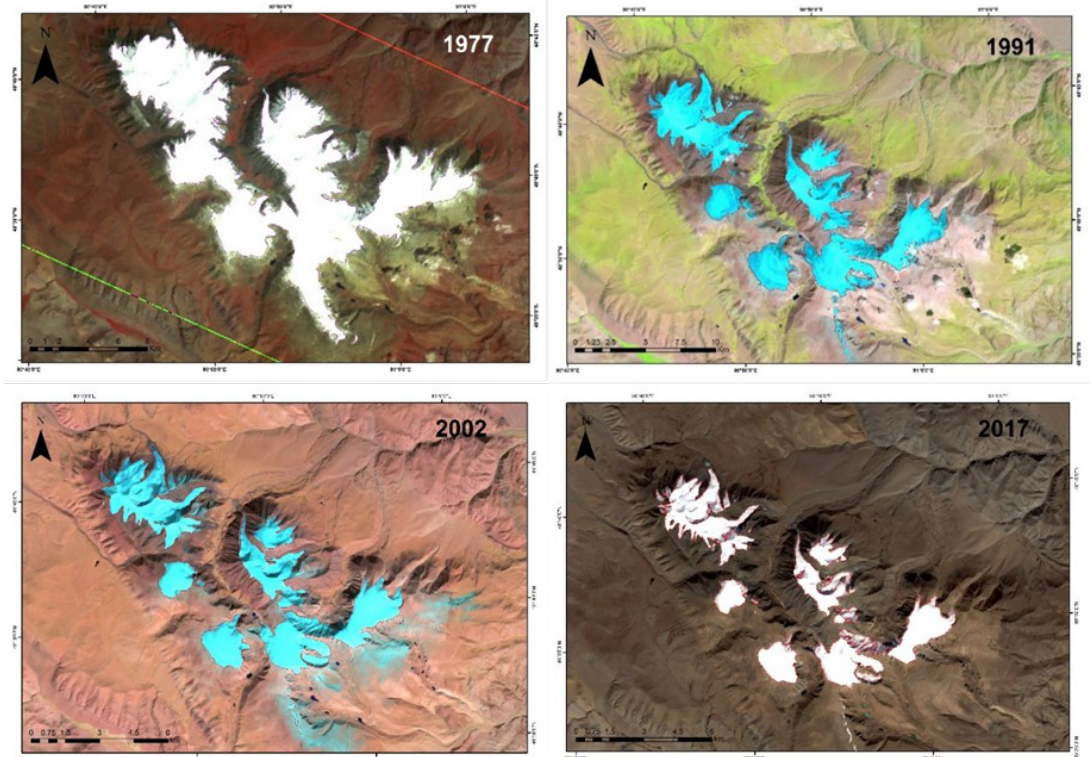
Fig. 4. Spatial distribution of modern glaciers in Mt. Tsambagarav in 1977, 1991, 2002 and